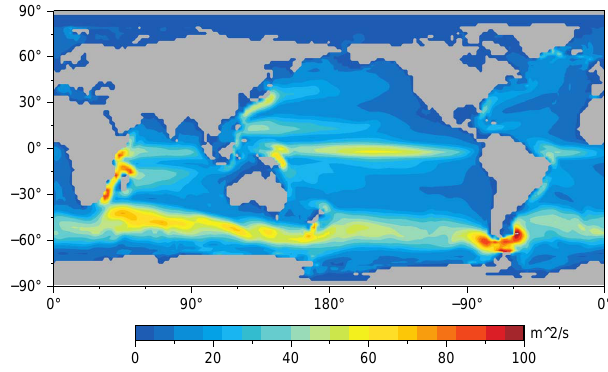
Figure 5. Influence of the spatially variable conductivity on the variability of the motionally induced magnetic field.